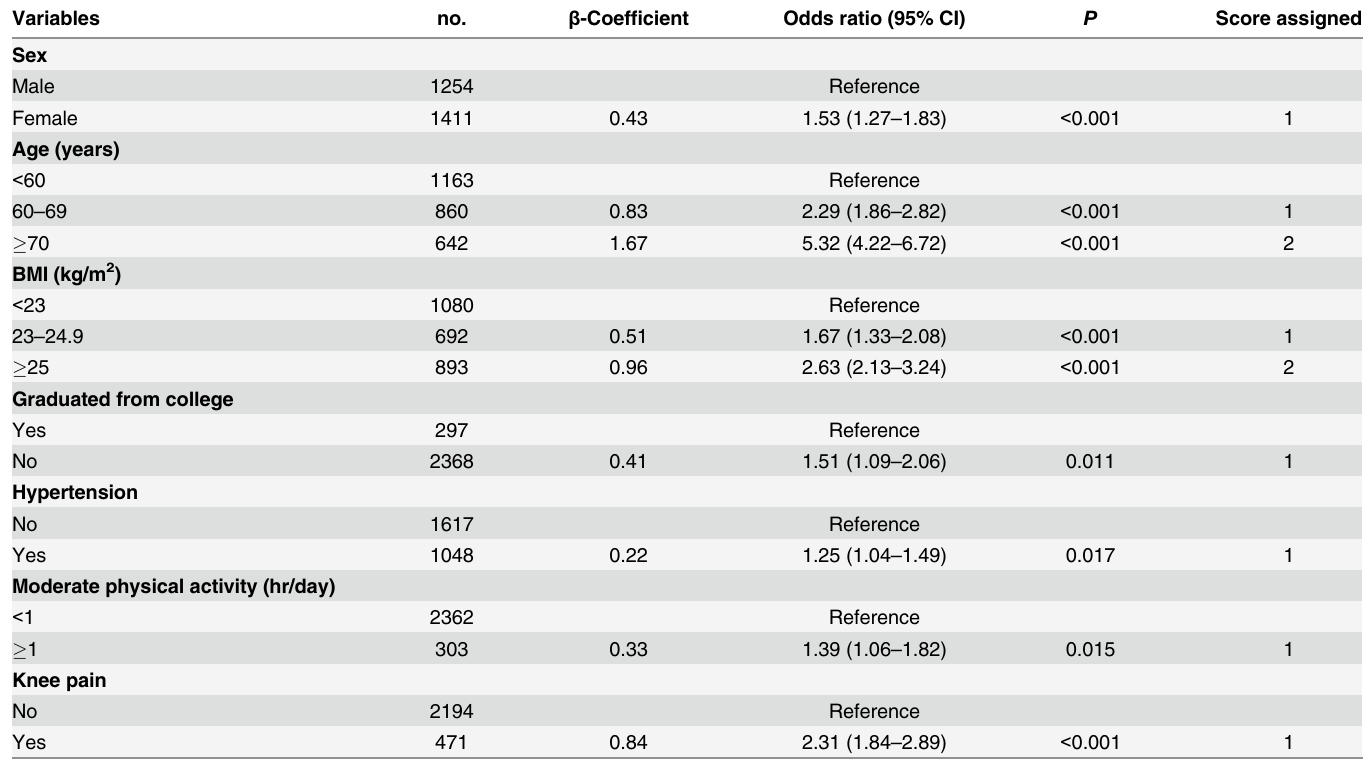
Table 2. Multivariate logistic regression analysis for related factors with radiographic knee osteoarthritis in study population, KNHANES V-1.